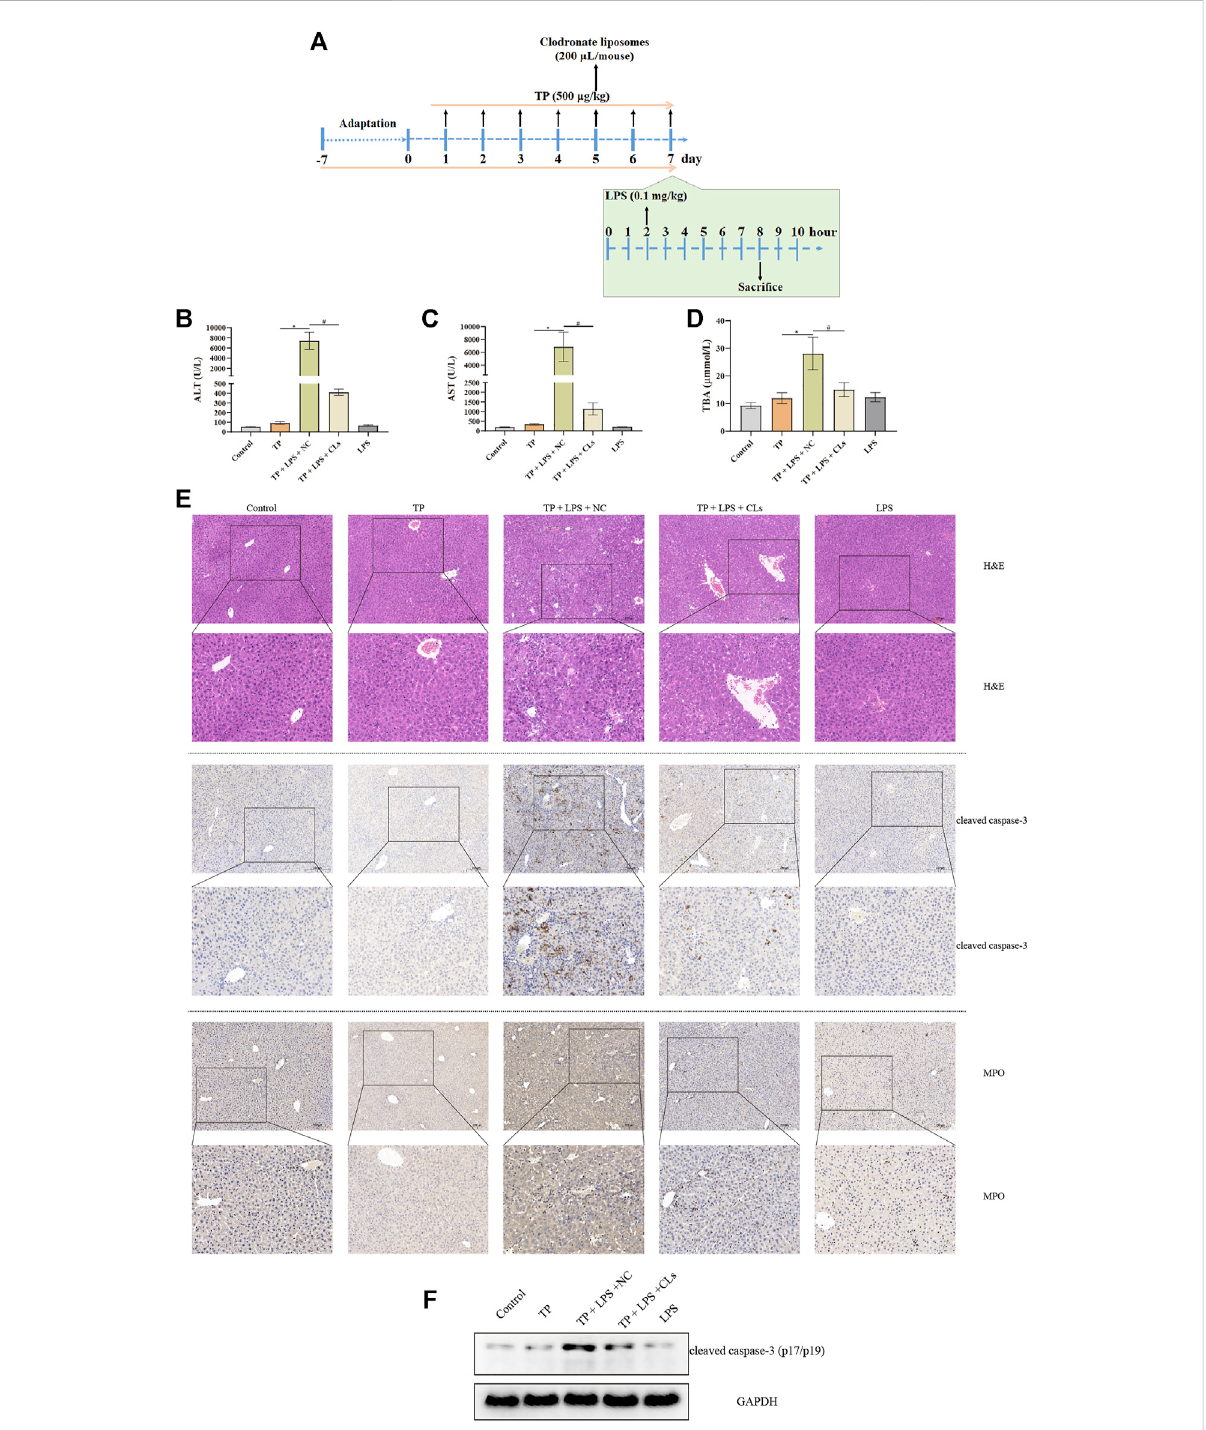
FIGURE 3 Depletion of macrophages alleviated TP-induced indirect hepatotoxicity, accompanied by relieving in fl ammatory reaction and hepatocyte apoptosis. (A) Schematic presentation of the experimental procedure to investigate the effect of depletion of macrophages in TP/LPS-induced hepatotoxicity. (B – D) LevelsofserumALT,AST,andTBAinmicehavinglivermacrophagesandthentreatmentwithTPandLPS( n =8). (E) Picturesof liver tissue sections stained by H&E (top panels), analyzed by IHC for apoptosis marker cleaved caspase-3 (middle panels) or analyzed by in fl ammatory marker MPO (bottom panels) (×200). (F) Representative protein bands of cleaved caspase-3 after the depletion of macrophages, with GAPDH as the loading control. Results were expressed as means ± SEM. Statistical analysis was performed using One-way ANOVA followed by Tukey ’ s Multiple Comparison Test. p < 0.05 was considered to be statistically